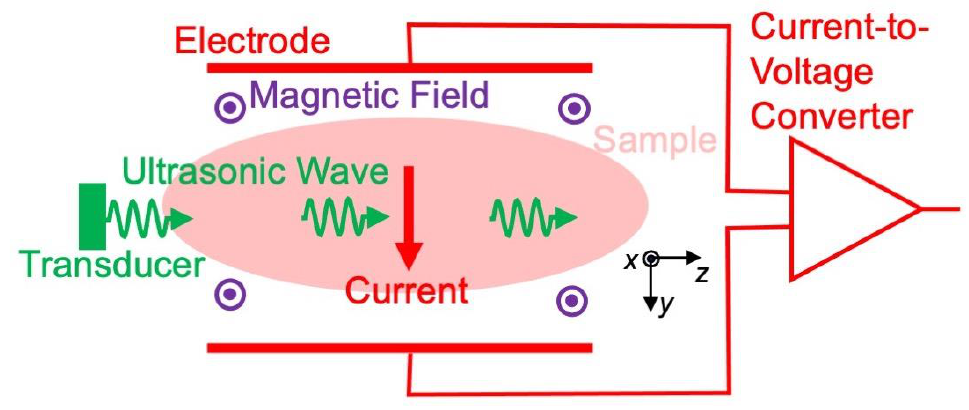
Figure 6. Magneto-acousto-electrical